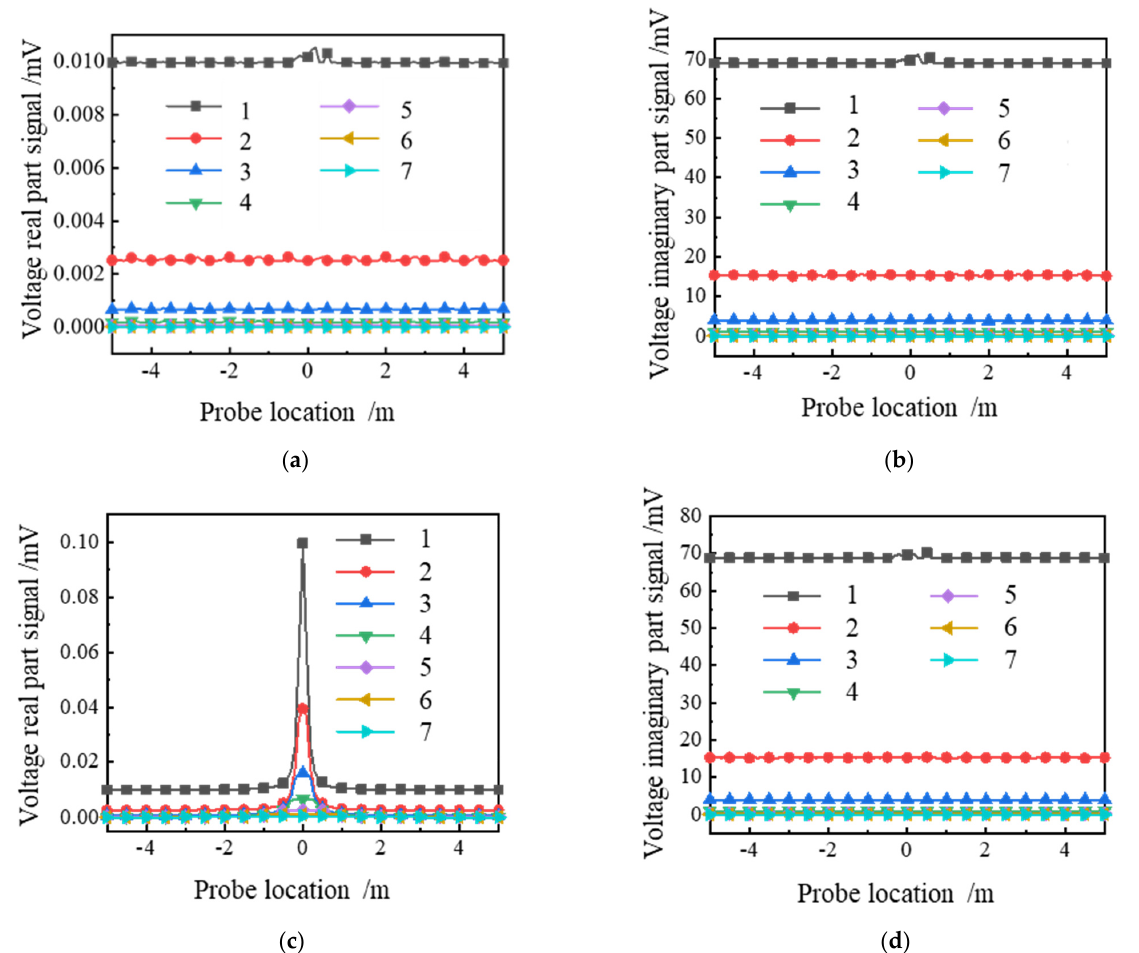
Figure 5. Electromagnetic signal response curves with and without proppant: ( a ) real part signal without fracture; ( b ) imaginary part signal without fracture; ( c ) real part signal without fracture; ( d ) imaginary part signal without fracture.